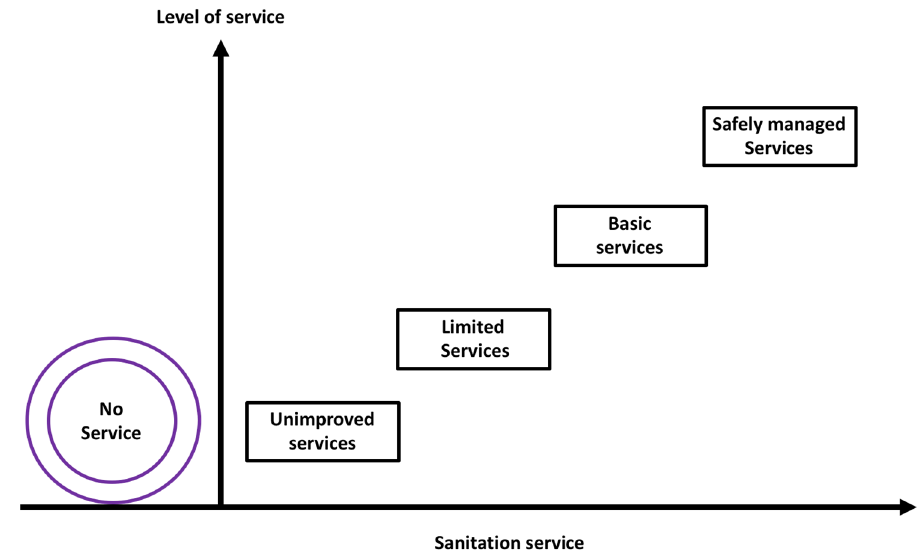
Figure 1. Joint Monitoring Program sanitation service ladder.